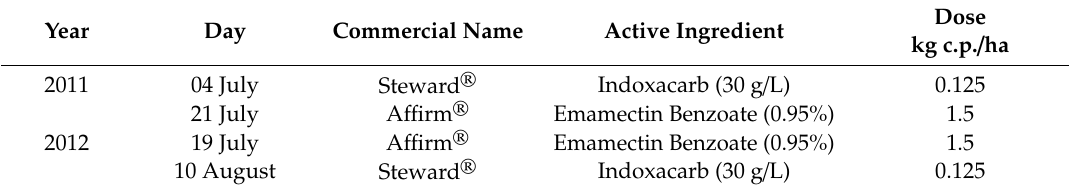
Table 1. Insecticide sprays applied to tomato fields for H. armigera